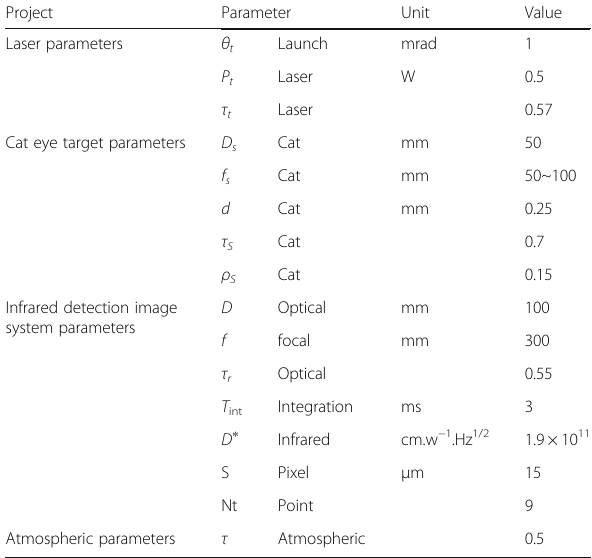
Table 1 Image capture capability parameter table Project